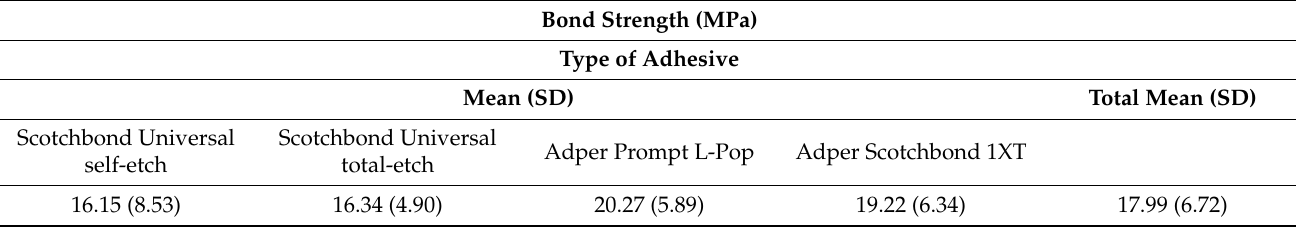
Table 4. BS descriptive analysis depending on the type of adhesive.